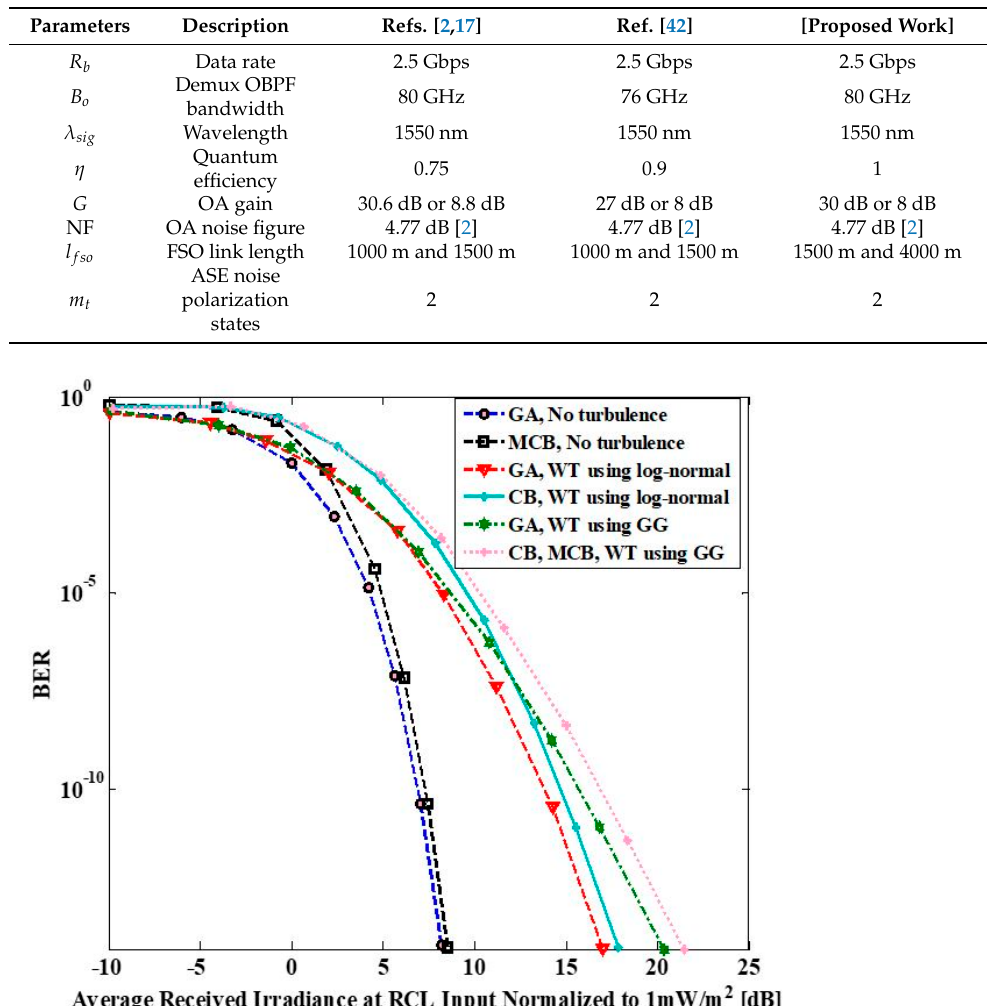
Figure 2. The bit error rate (BER) against an average irradiance [dB] for no turbulence (NT), and WT using Gamma-Gamma (GG) model and log-normal distribution.